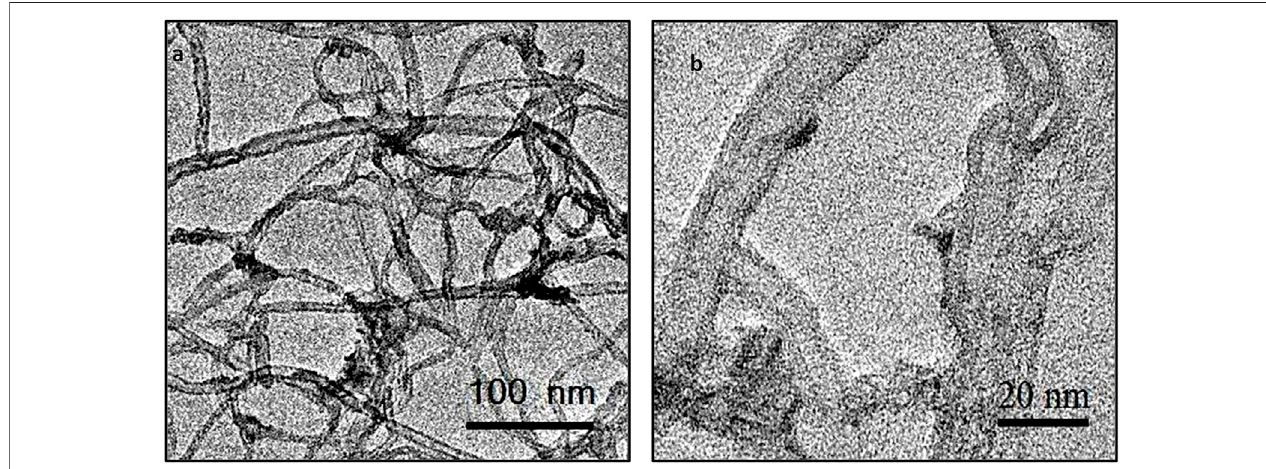
FIGURE 4 | TEMs of fCNT/TiO 2 .ZrO 2 (36)500 ° C.1: (A) general view and (B) detailed view of NPs on fCNT walls.